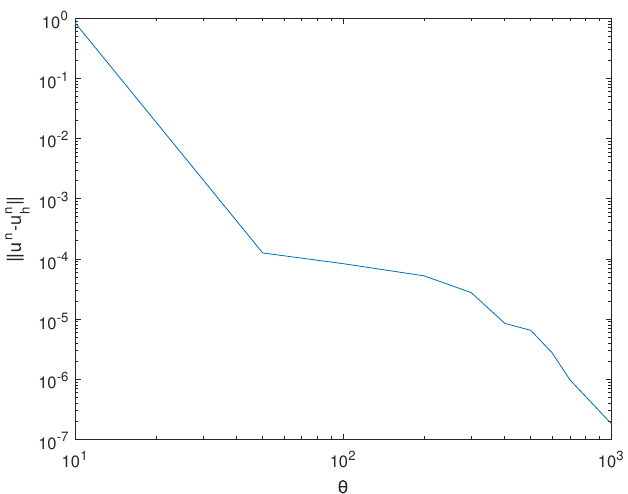
(cid:107) L 2 at mesh 40 and t h